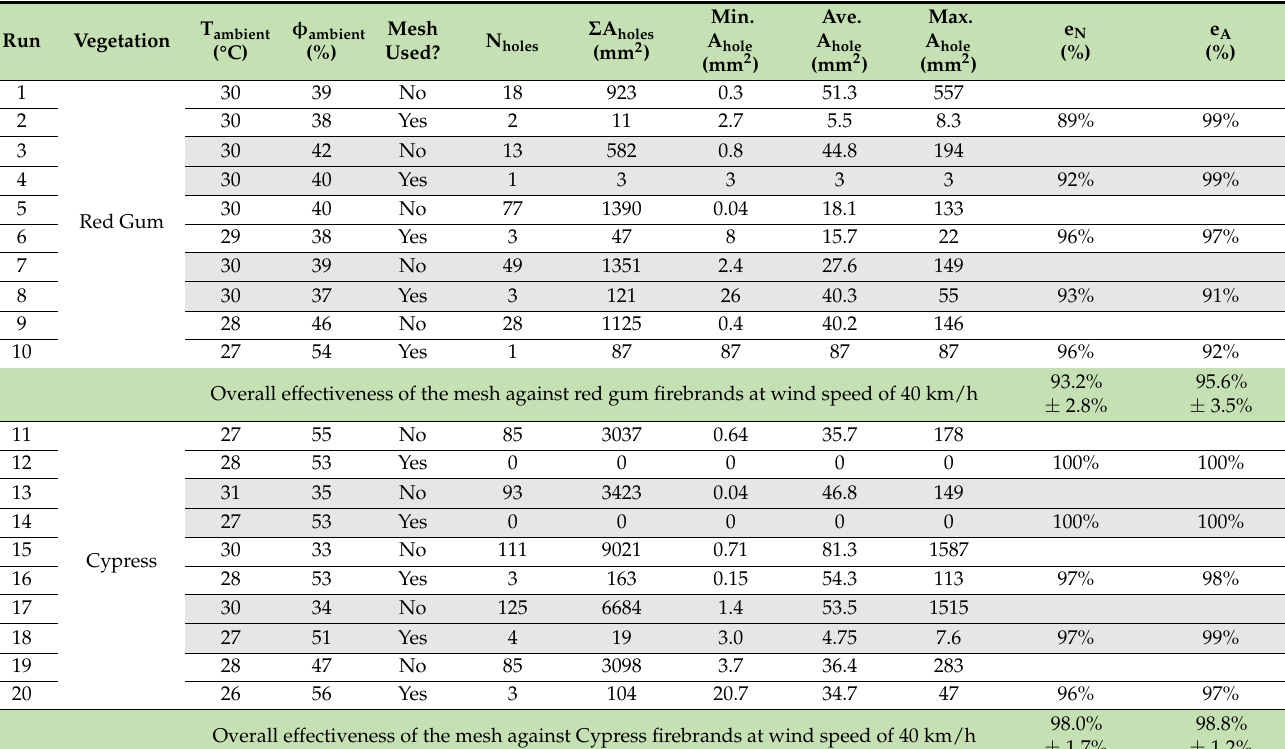
Table 1. The numbers of holes created by 0.2 kg firebrands of red gum woodchips at a wind speed of 40 km/h on a plastic sheet of 0.02 mm thickness with and without the stainless-steel mesh with an aperture of 1.67 mm and wire diameter of 0.45 mm which represents a porosity of 62%. minimum, average and maximum hole area on the plastic sheet at the end of experiments.